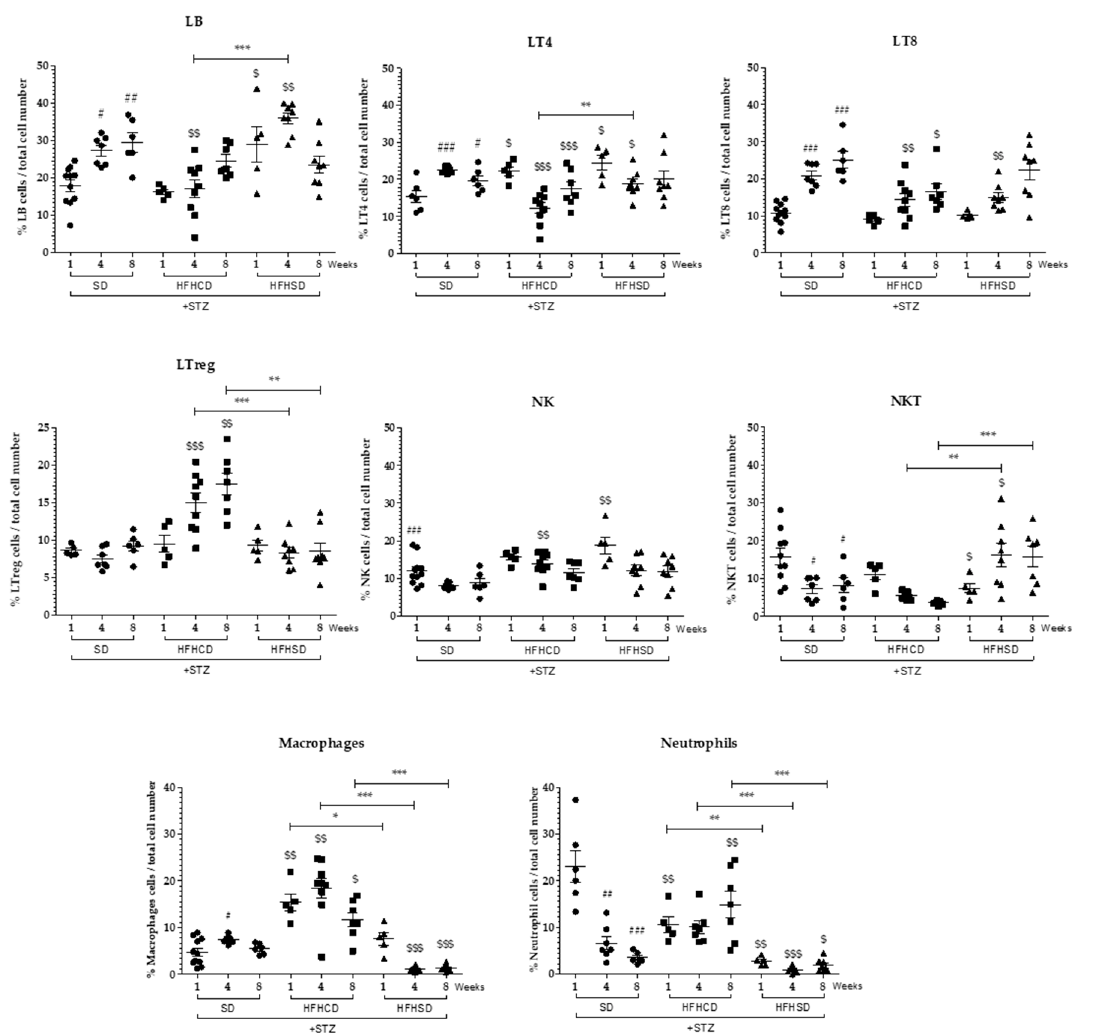
Figure 5. Analysis of hepatic immune infiltrates during HCC development on NASH background. Diabetic (STZ) C57Bl6/J male mice were fed either a SD, a HFHCD or a HFHSD during 1, 4 and 8 weeks. Percentages of B lymphocytes (LB), CD4+ T cells (LT4), CD8+ T cells (LT8), regulatory T cells (LTreg), Natural Killer (NK) cells, Natural Killer T (NKT) cells, macrophages and neutrophils in the different experimental conditions (percentage of total infiltrated immune cells). For all graph, each black dots, black squares and black triangles represent individuals from the different groups: diabetic mice under SD, diabetic mice under HFHCD or HFHSD, respectively. # p < 0.05; ## p < 0.01 and ### p < 0.001 compared diabetic mice under SD to healthy mice under SD; $ p < 0.05; $$ p < 0.01 and $$$ p < 0.001 compared diabetic mice under HFHCD or HFHSD to diabetic mice under SD; * p < 0.05; ** p < 0.01 and *** p < 0.001 compared diabetic mice under HFHCD to diabetic mice under HFHSD at the same time point.